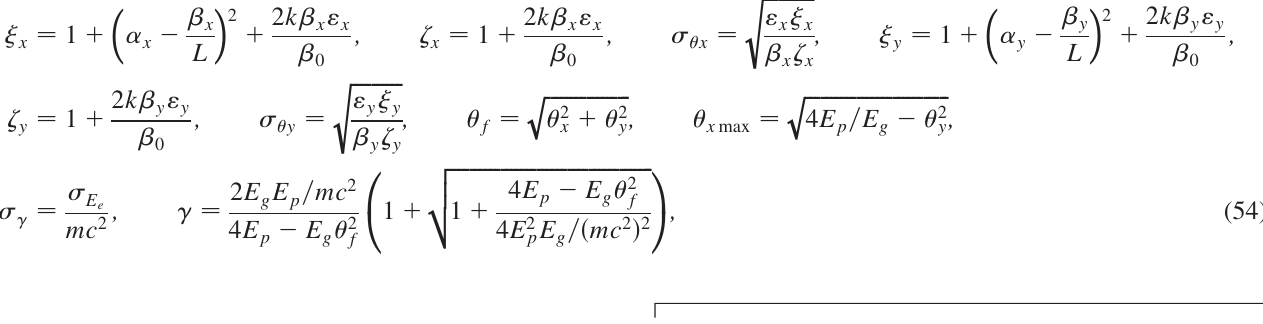
ffiffiffiffiffiffiffiffiffiffiffiffiffiffiffiffiffi